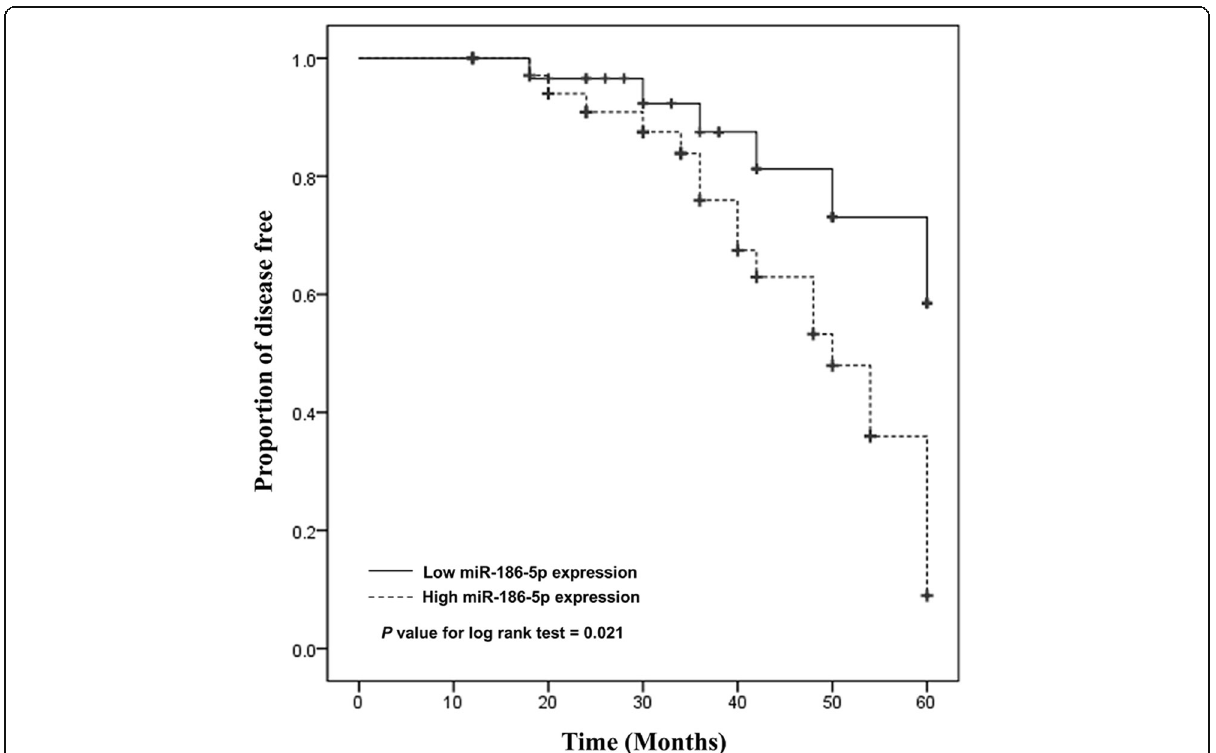
Fig. 3 Kaplan-Meier method was applied for the evaluation of the predictive value of miR-186-5p for the occurrence of CIE in asymptomatic CAS patients. It was observed that high miR-186-5p level was associated with the occurrence of CIEs